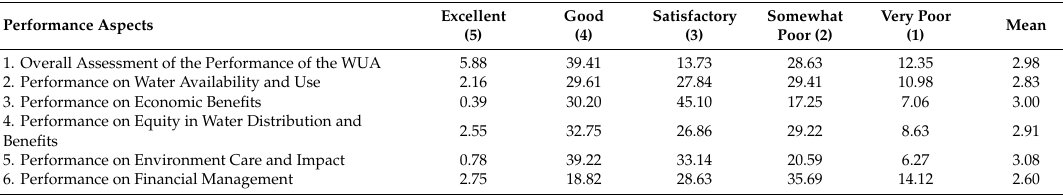
Table 9. Assessment of the performance of